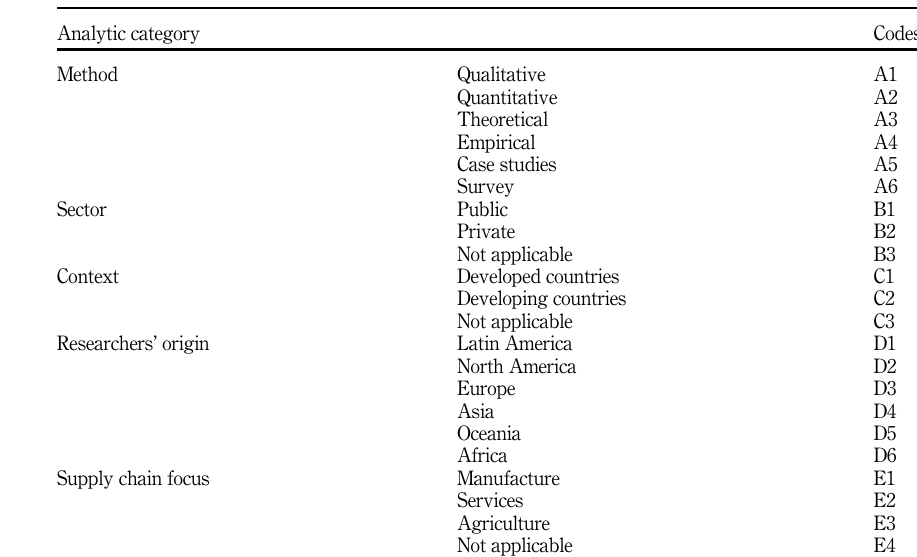
Table 3. Systematic review structure